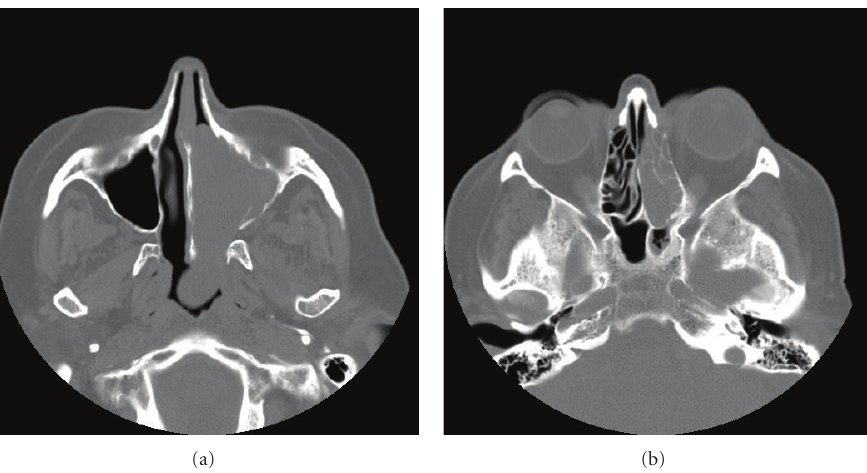
Figure 1: CT scans taken in 2006 after the patient’s initial referral to ENT. (a) CT scan showing a mass in the left nasal cavity, and (b) CT scan showing the mass in the left ethmoid sinus, The mass was initially thought to be an inverted papilloma, but following histology it was shown to be an intestinal-type adenocarcinoma.